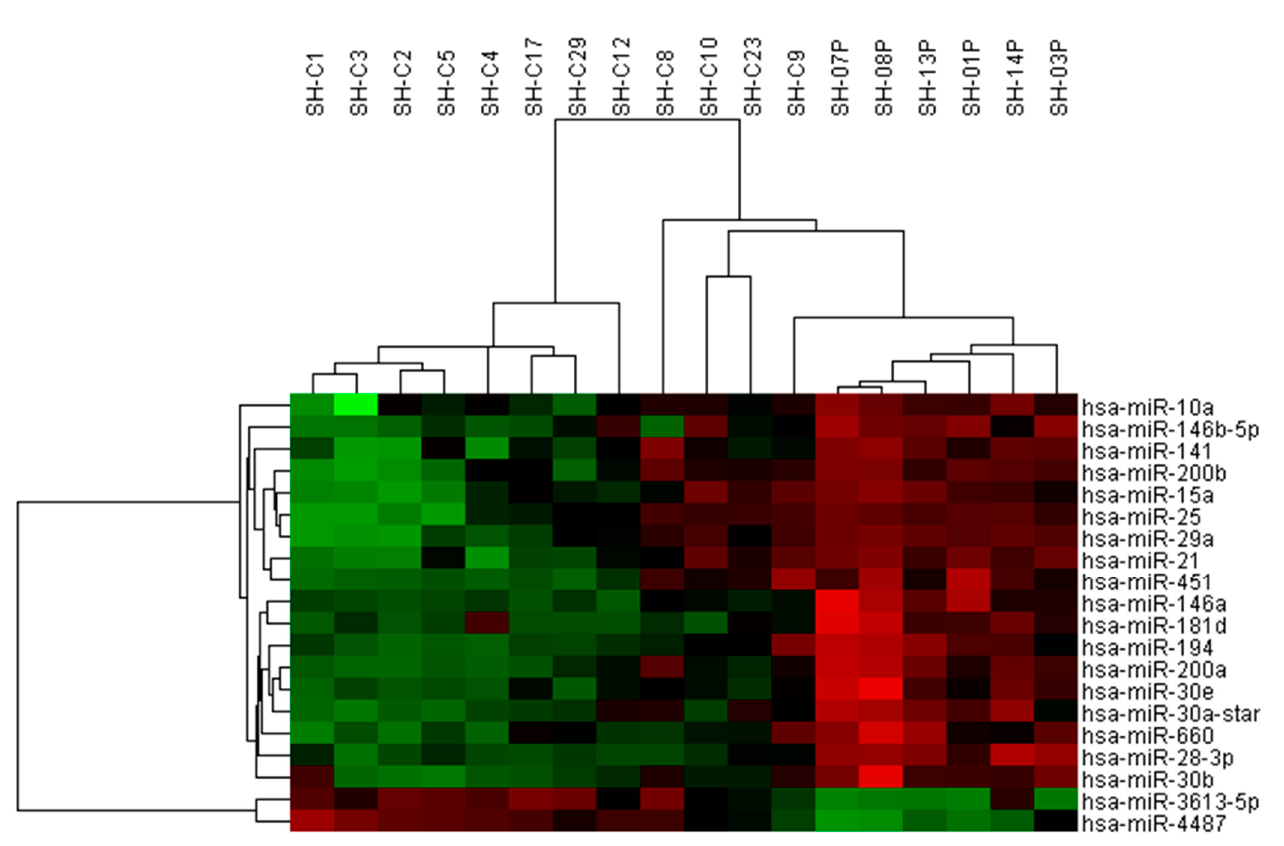
Figure 1. Among patients with SH/CH-nonA, the levels of 20 miRNAs were significantly higher in those who progressed to EC than in those who did not. Hierarchical clustering analysis of the miRNA profiles of the case group (SH-01P, SH-03P, SH-07P, SH-08P, SH-13P, and SH-14P) and control group (SH-C1, SH-C2, SH-C3, SH-C4, SH-C5, SH-08P, SH-C9, SH-C10, SH-12, SH-17, SH-23, and SH-29) was performed. Downregulated miRNAs are presented in green, and upregulated miRNAs are presented in red.